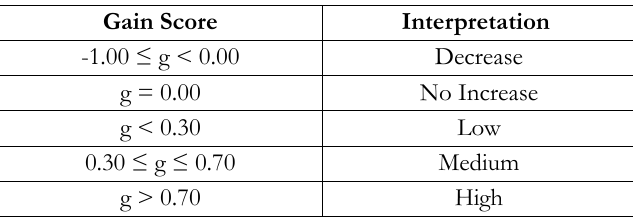
Table 3. Interpretation of Normalized